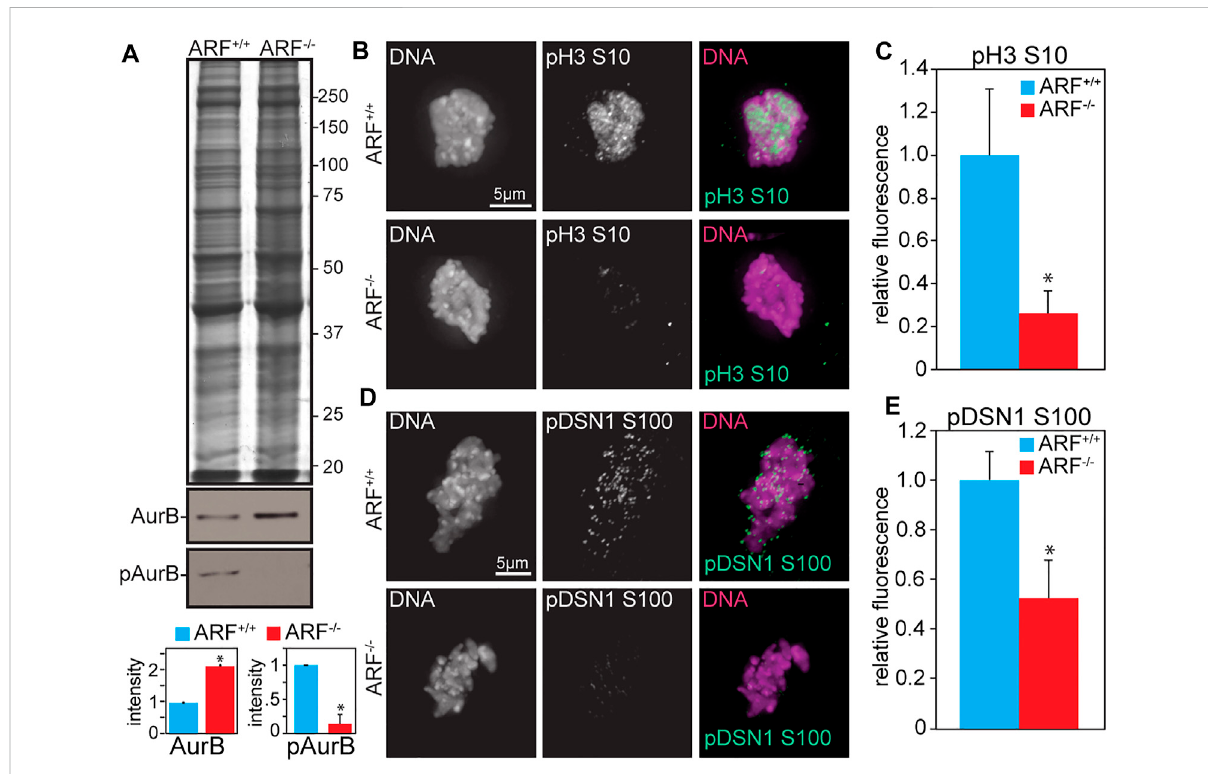
ARF loss results in increased Aurora B protein but reduced Aurora B activity. (A) Immunoblot of ARF +/+ and ARF − / − MEFs showing Aurora B is increased in ARF − / − MEFs while pT237 (active) Aurora B is decreased. Coomassie is shown as a loading control. Quantitation is shown below. (B –